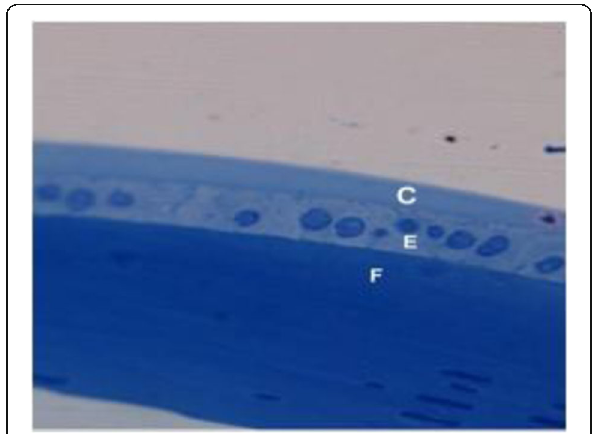
Fig. 12 Light micrograph of rat lens of diabetic model treated with TUDCA (group 4) showing lens capsule (C), epithelium (E), and fibers (F) almost devoid of pathological changes (Toluidine blue × 500)